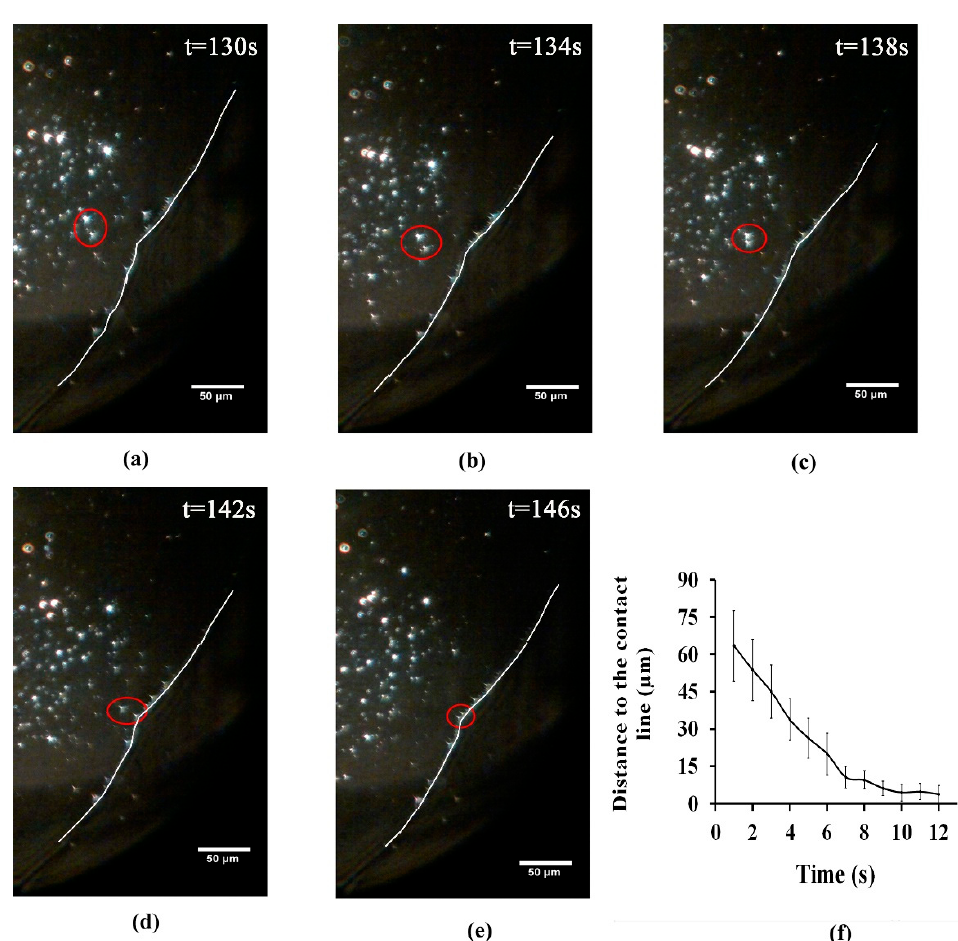
Figure 2. Sequential images ( a – e ) showing phage movement towards the contact line for diluted dialyzed phage (10 9 pfu/mL); and ( f ) illustrates phage distance to the contact lines vs. time for the randomly-selected phage nanoparticles near the contact line, within 3–5 min after droplet contact with the glass coverslip.